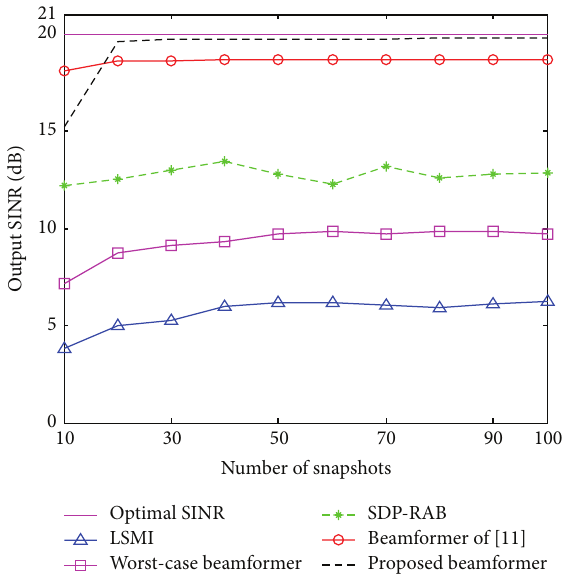
Figure 8: Output SINR versus the number of snapshots in the case of coherent local scattering.